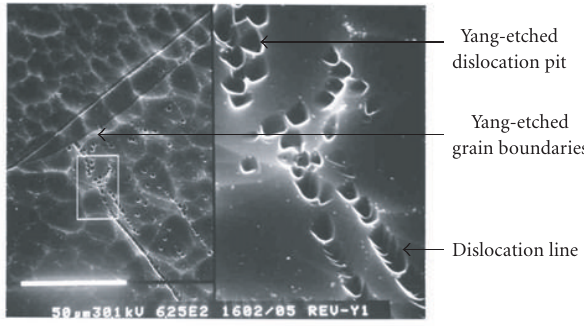
Figure 2: Crystalline defects delineated by Yang etch on mc-Si.